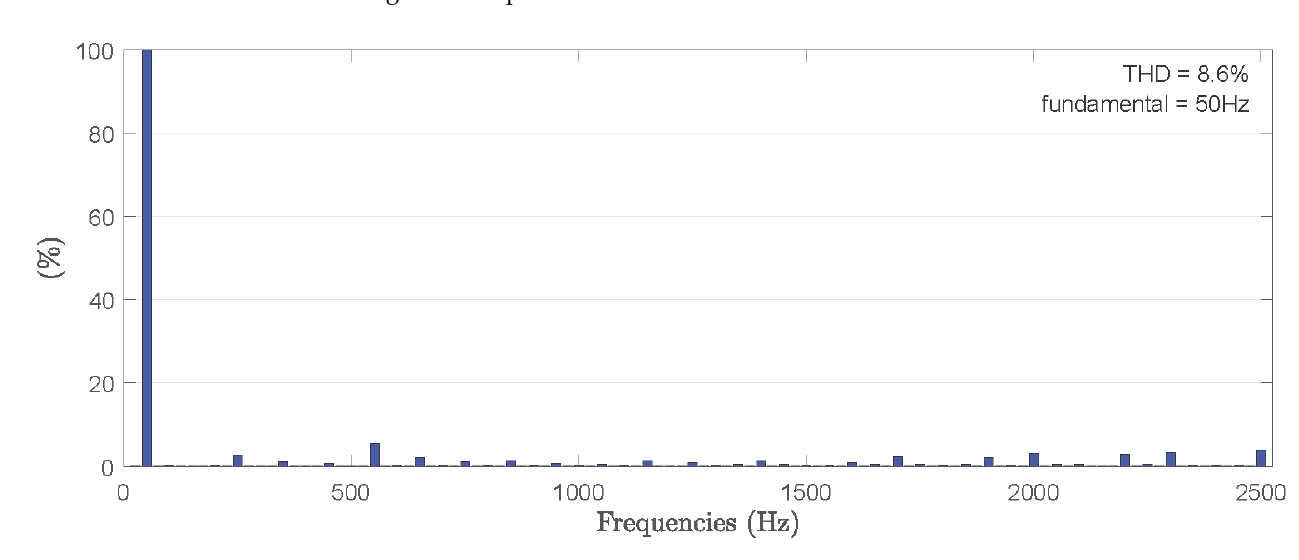
Figure 17. Frequency variation results versus changes in active power (winds gusts).